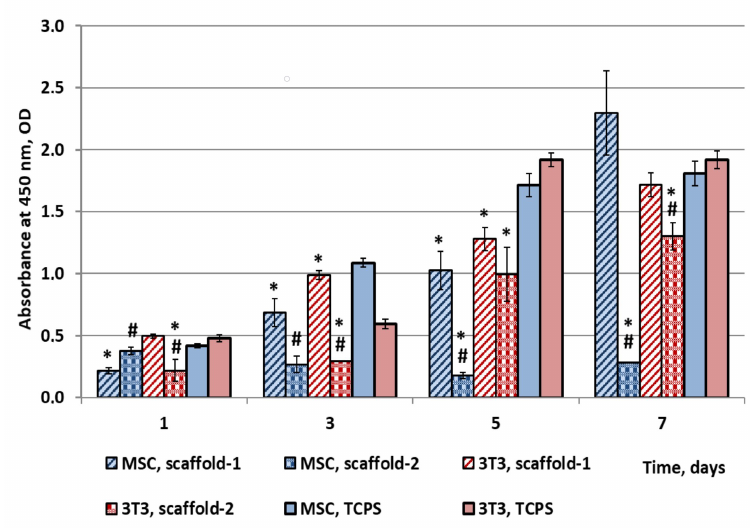
Figure 3. Adhesion and cell proliferation of MSCs and fibroblasts on scaffolds measured using XTT test; n = 6; * p < 0.05: scaffold-1 and scaffold-2 vs. TCPS; # p < 0.05: scaffold-2 vs. scaffold-1 for MSC and 3T3 fibroblasts, respectively.